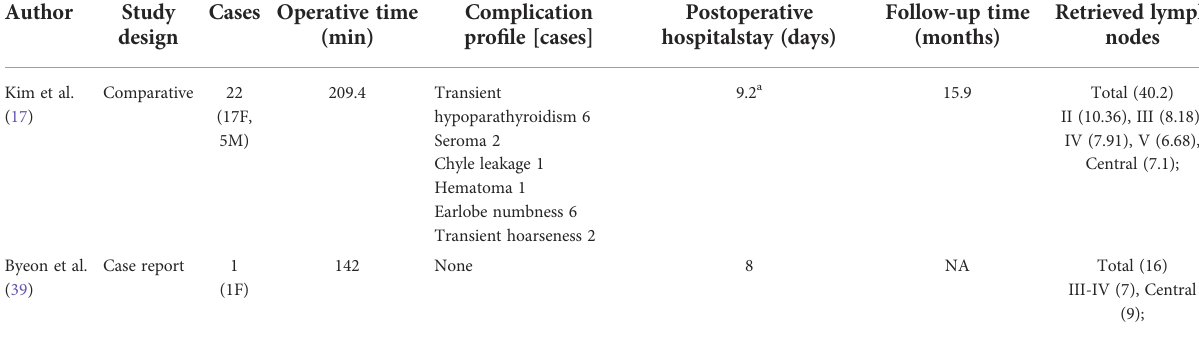
TABLE 6 Summary of studies of robotic TARA LND.